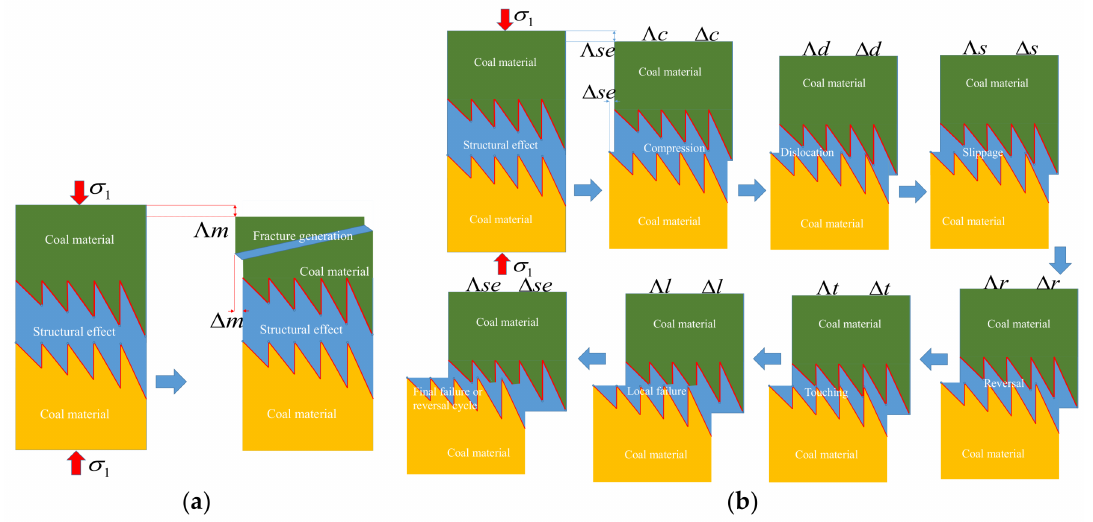
Figure 15. Deformation of fractured coal. ( a ) Material deformation. ( b ) Structural